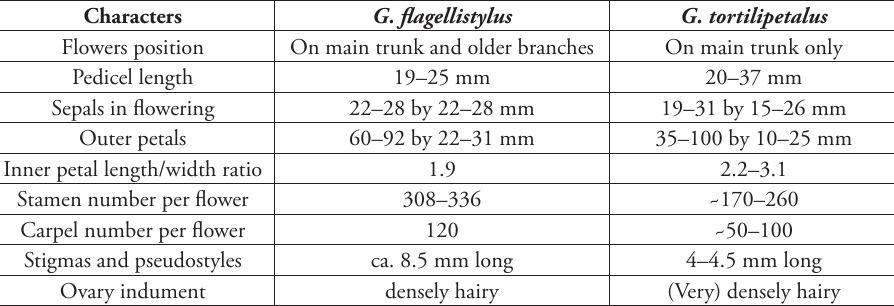
Table 1. Morphological comparison between Goniothalamus flagellistylus sp. nov. and G. tortilipetalus (modified from Henderson 1933; Saunders 2003; Saunders and Chalermglin